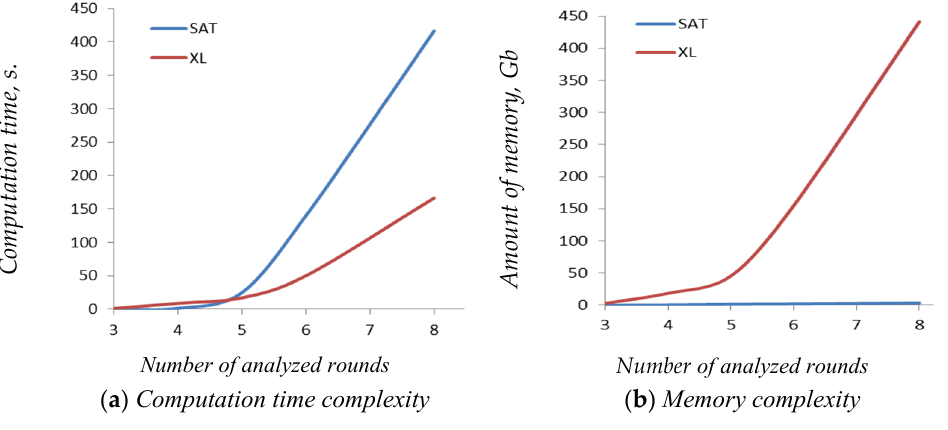
Figure 5. Search complexity with different numbers of Magma rounds.